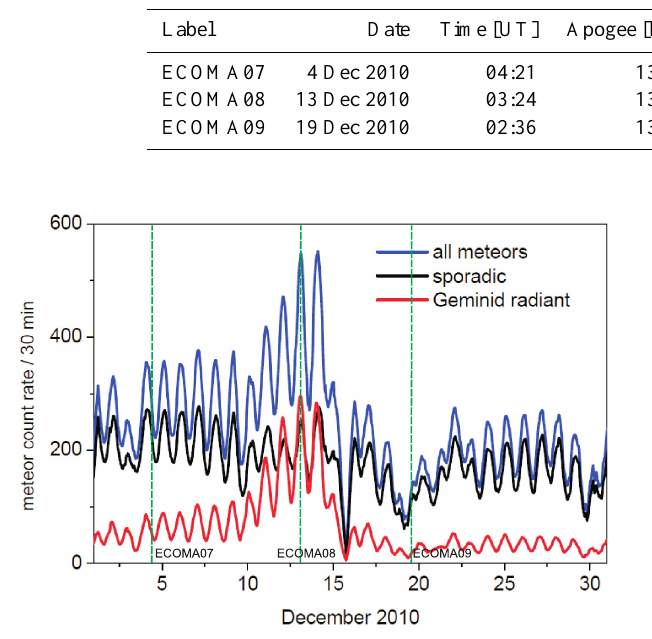
Fig. 4. Time variation of half-hourly meteor count rates as observed with the IAP meteor radar located in the vicinity of the Andøya Rocket Range in December 2010. The blue curve shows the total count rate, whereas the red curve is for Geminid meteors and the black curve for the background sporadics. Green dashed vertical lines indicate the launch times of the three ECOMA sounding rock-